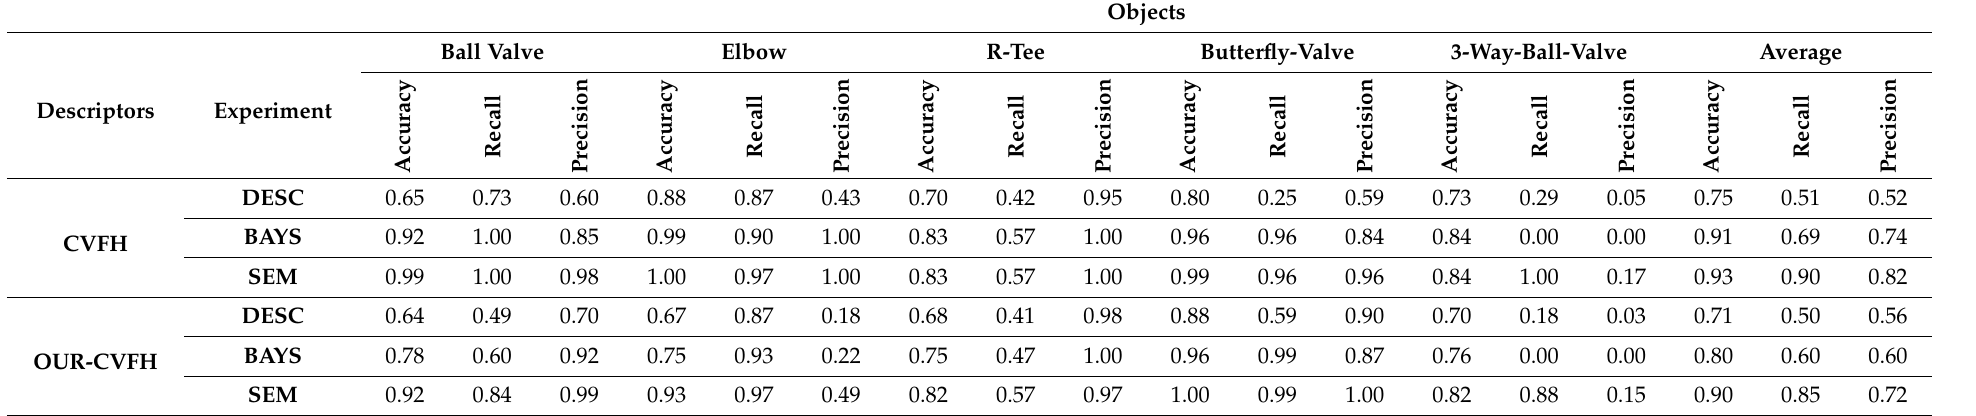
Table 6. Assessment of the recognition performance through Accuracy, Recall and Precision. Qualitative labels used in the text: bad (0–0.2); poor (0.2–0.4); medium; good; excellent.